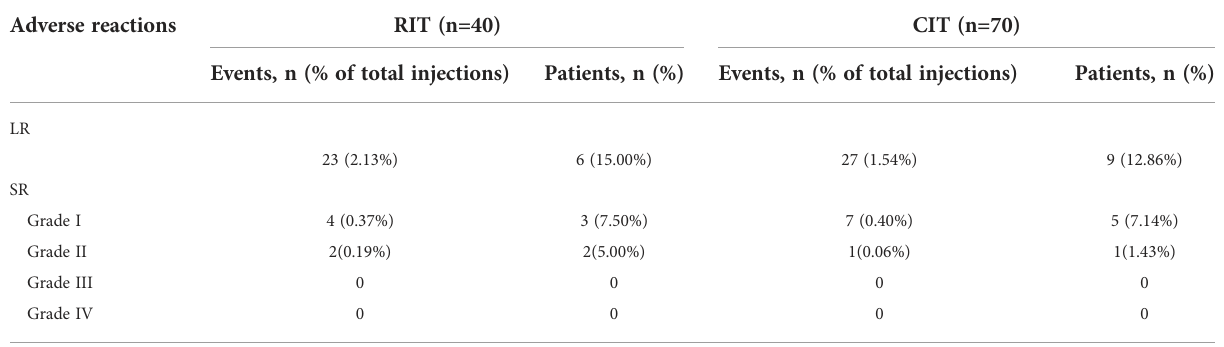
TABLE 3 Adverse reactions in the RIT and CIT groups.